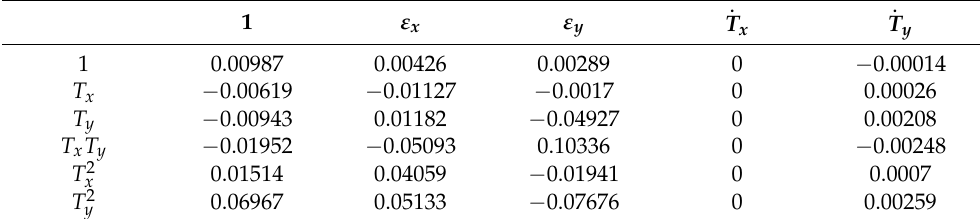
Table 10. Fitting results for (cid:101) D ty , ty